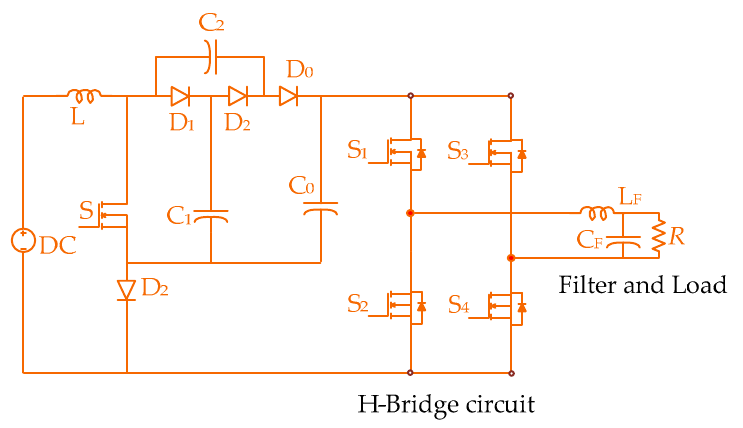
Figure 19. Single cell voltage multiplier cell based quasi-switched boost inverter.